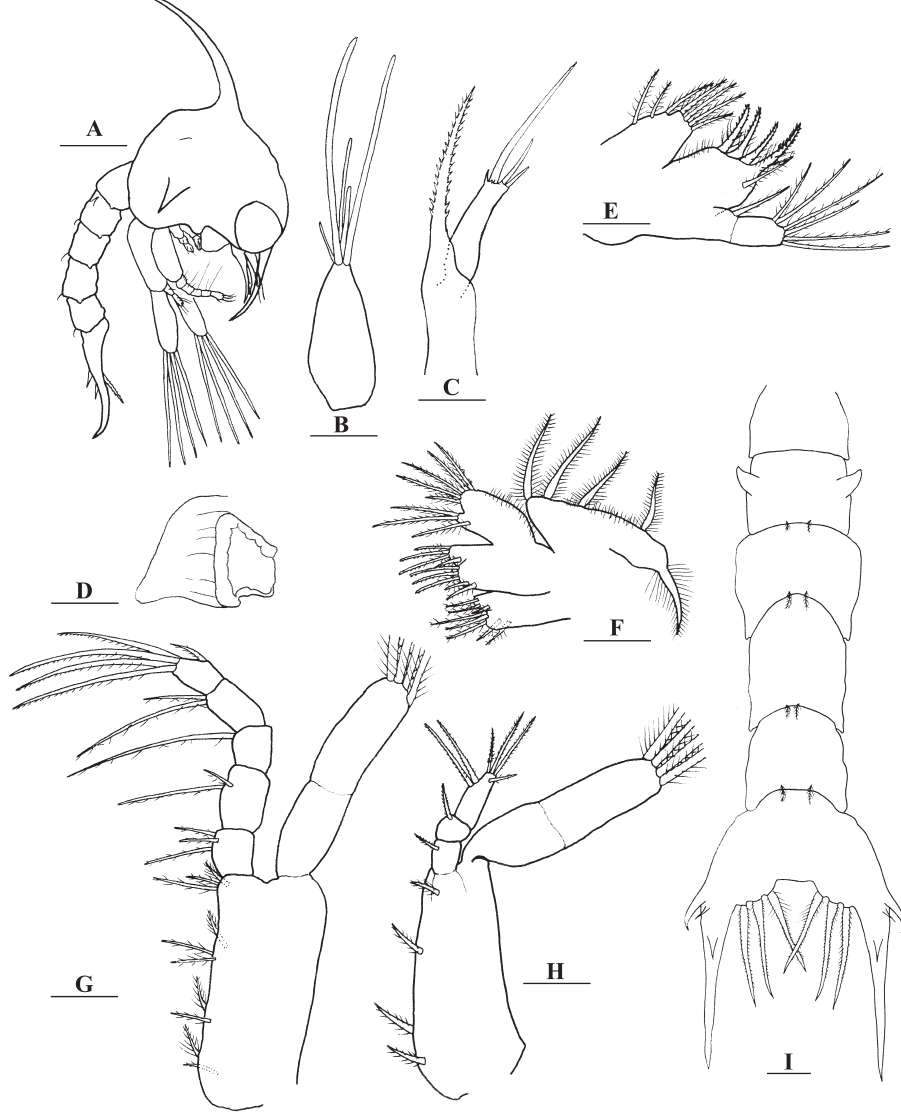
Fig . 1. – Pilumnoides hassleri . Zoea i. A, whole animal, lateral view; B, antennule; C, antenna; d, mandible; e, maxillule; F, maxilla; G, first maxilliped; h, second maxilliped; i, abdomen. scale bars. A, 0.2 mm; B-h, 0.05 mm; i, 0.1